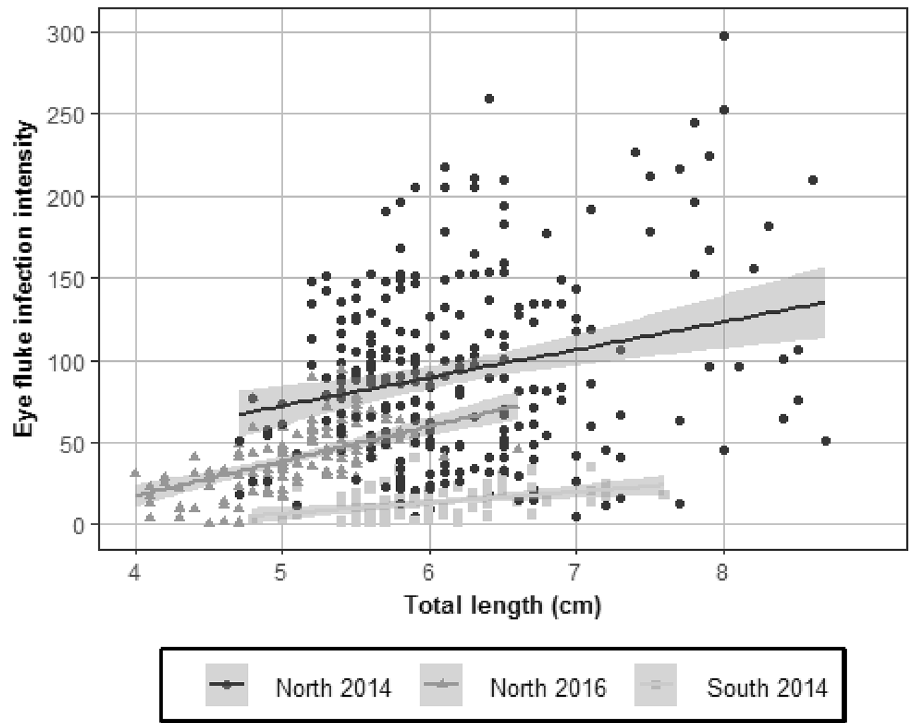
Figure 1. Relationship between eye fluke infection intensity and the total length of YOY perch ( Perca fluviatilis ) from two sampling sites of Lake Müggelsee (“South” and “North”) in 2014 and 2016. The lines represent the best linear fit (South 2014: y = 6.66 x – 26.86; North 2014: y = 16.94 x – 12.22; North 2016: y = 21.23 x – 67.4957). The grey shading represents 95% confidence